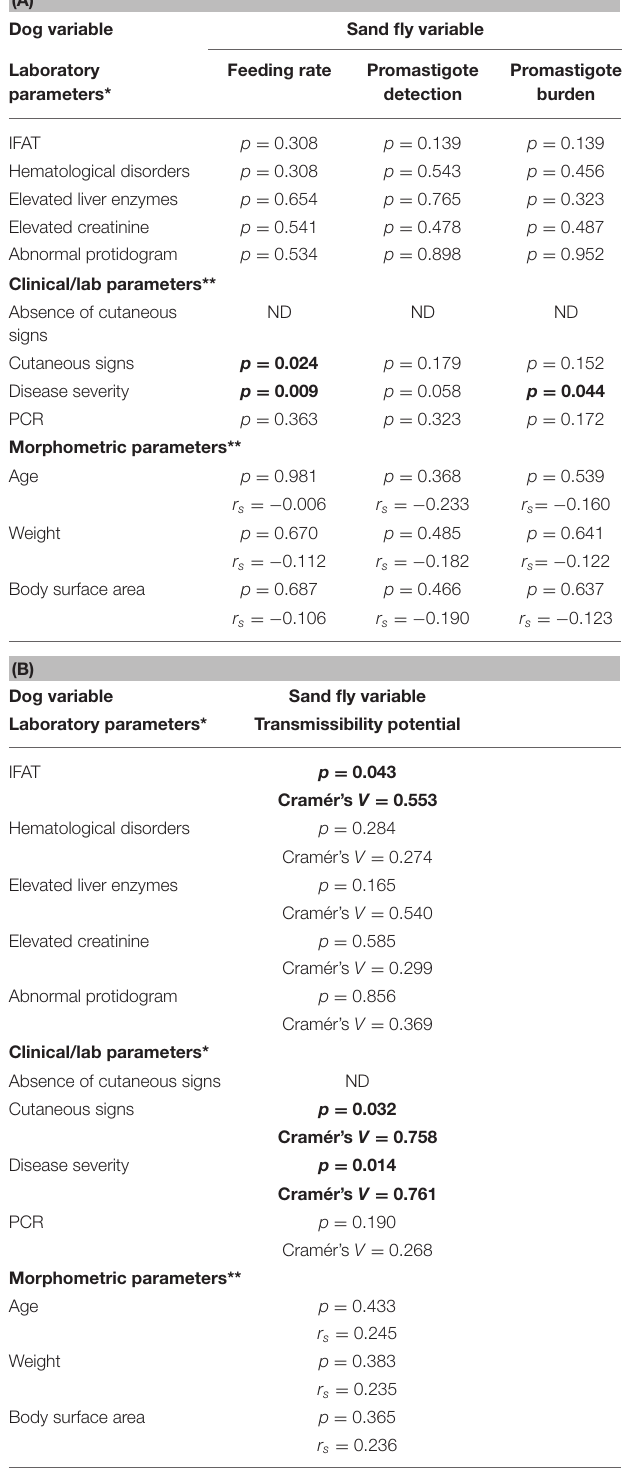
TABLE 3 | Xenodiagnosis results: sand flies feeding rate and promastigote infection. Dog no. Feeding rate (%)